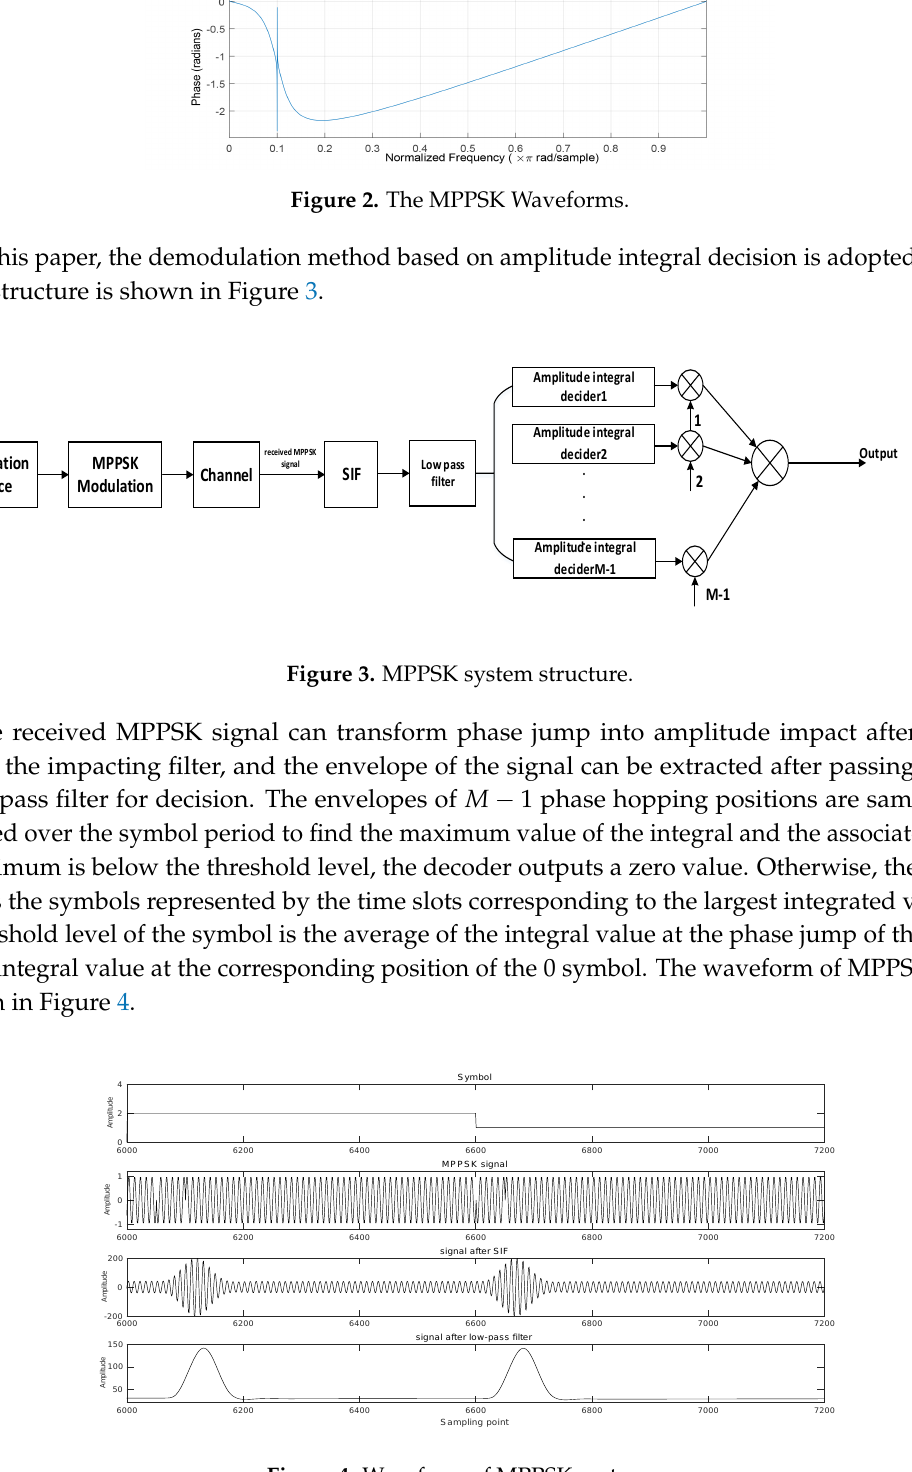
Figure 4. Waveform of MPPSK